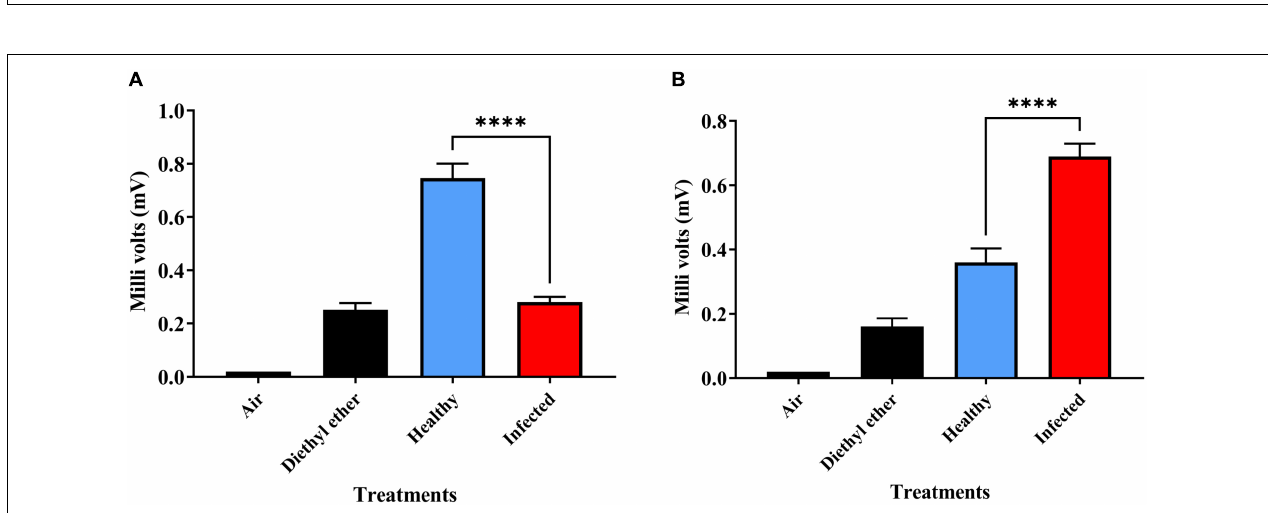
FIGURE 3 | Electroanntenogram response of B. tabaci to healthy and ChLCV infected chili plant volatiles, (A) viruliferous females to healthy (blue bars) and ChLCV infected volatiles (red bars) (B) non-viruliferous females to healthy and ChLCV infected plant volatiles. ****denotes P < 0.0001.